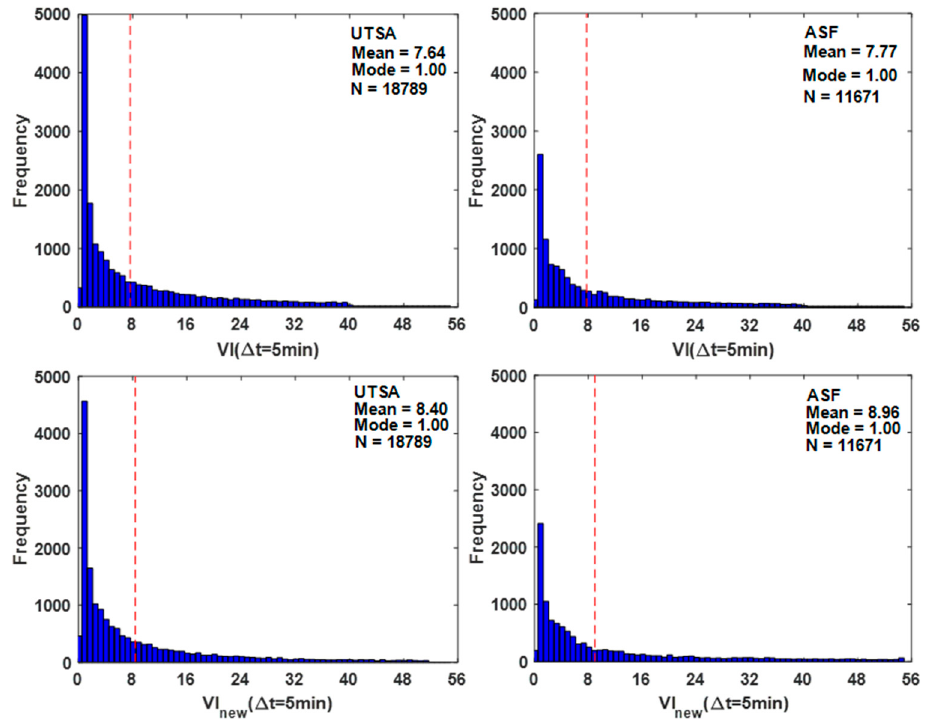
Figure 8. Histograms of the variability index (VI) ( upper panels ) and the modified version of the variability index (VI new ) ( lower panels ) at the 5-min time interval using all observations available at each of the two ground stations, UTSA ( left panels ) and ASF ( right panels ). The red dashed line in each panel indicates the average value of the index.